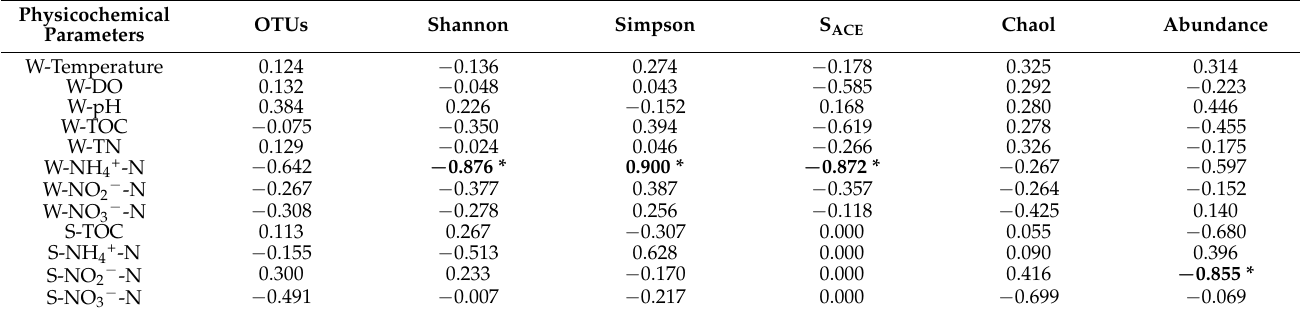
Table 5. Statistical analysis of anammox community structures with the physicochemical parameters in the recirculating pond aquaculture system (RPAS).